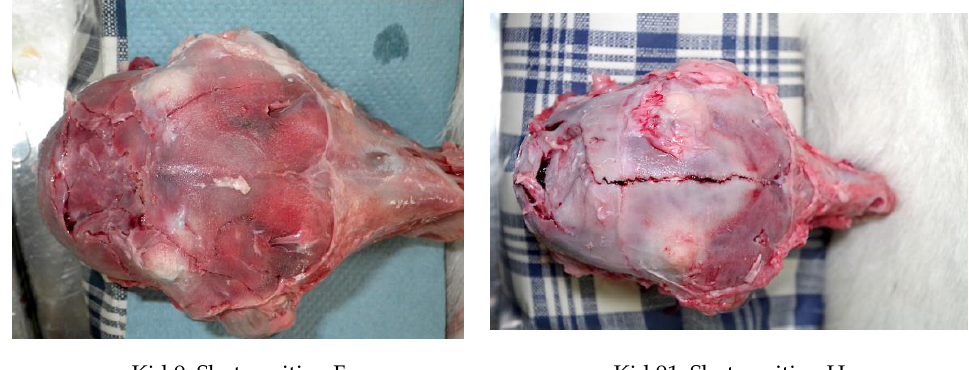
Figure 10. Variation in the fracture pattern produced between Kid 9 (forward shot position) and Kid 91 (caudal shot position).